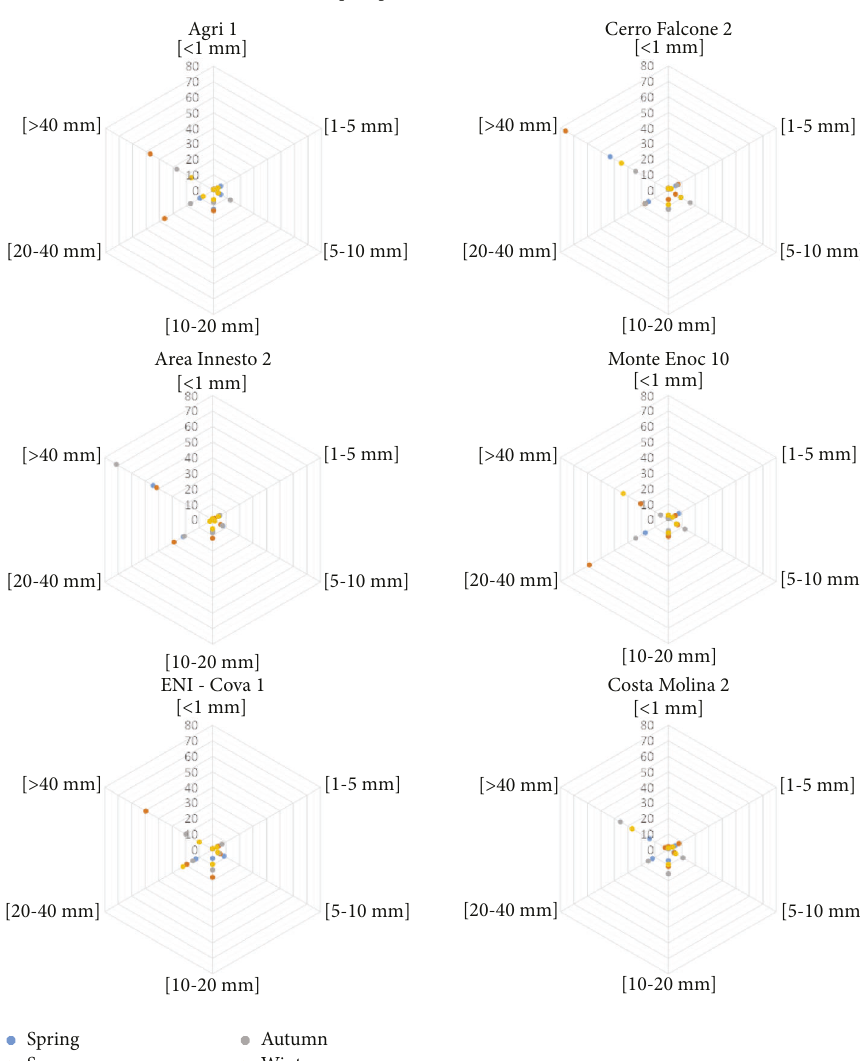
Figure 12: Seasonal MAE for precipitation thresholds in the two years of the observation period over the six weather stations at day +1 as lead time for the KALM-HD model with